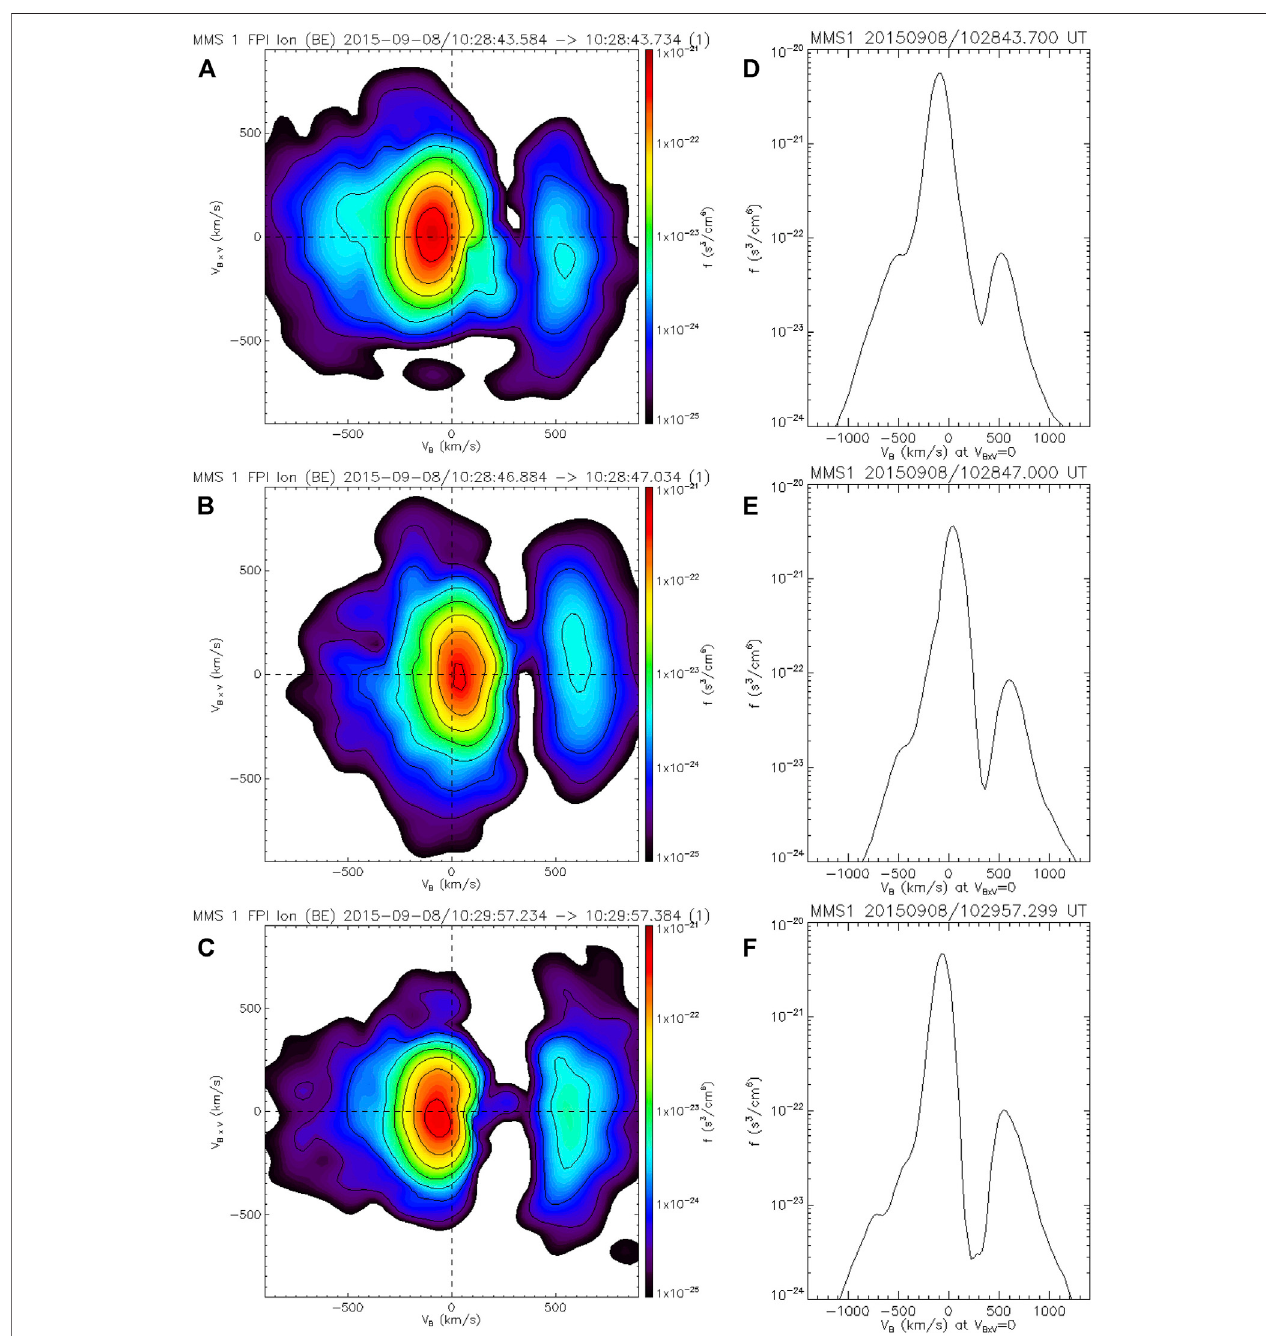
FIGURE 7 | MMS-1 ion velocity distributions: (A) Ion VDF at 1028:43.700 UT; (B) ion VDF at 1028:47.000 UT; (C) ion VDF at 1029:57.299 UT; (D) 1-D cut of ion VDFinpanel (A) ; (E) 1-DcutofionVDFinpanel (B) ; (F) 1-DcutofionVDFinpanel (C) .The2-DionphasespacedensityoftheVDFs (A – C) areshowninV BxV vsV B space. The 1-D cuts along V B are taken along V BxV (cid:1) 0